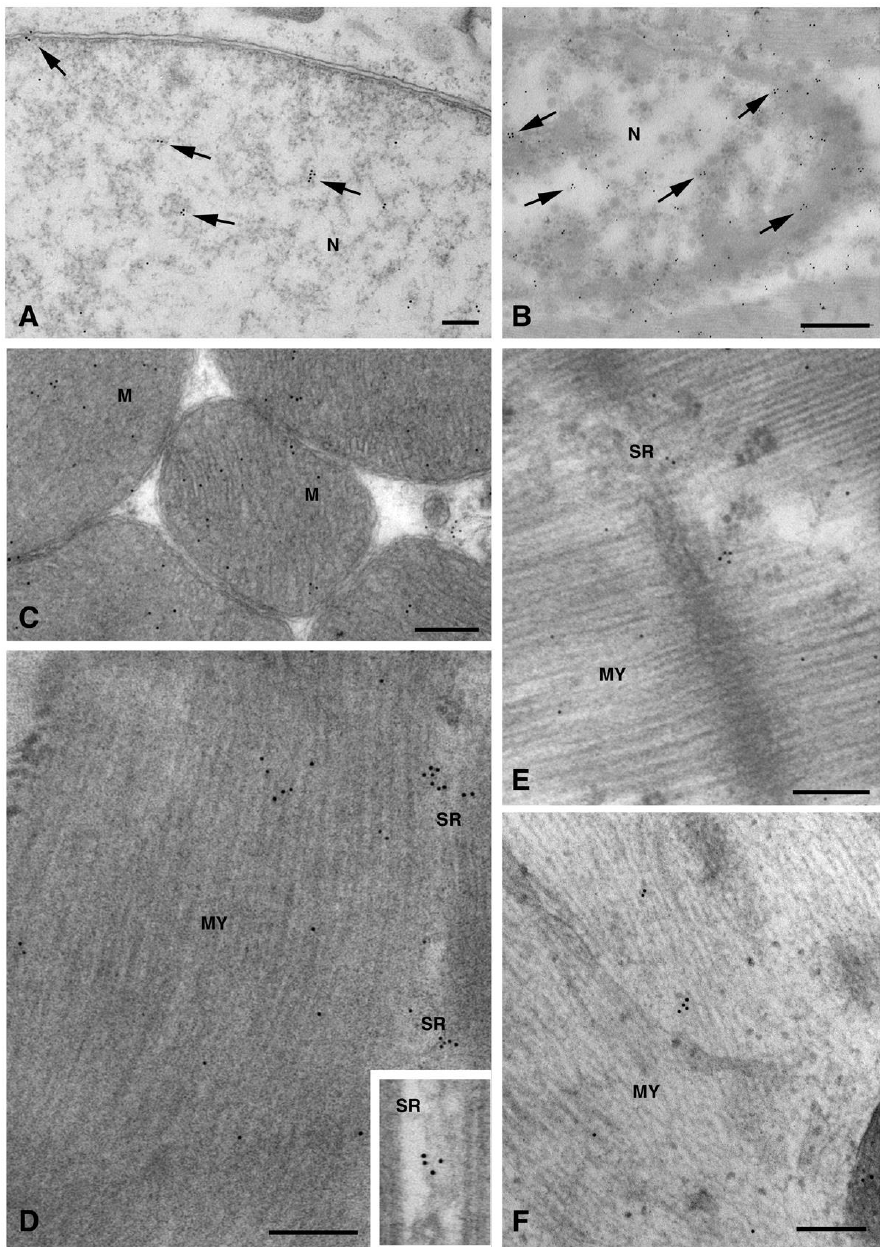
Figure 6. TEM immunogold analysis for Cx26 in non-canonical subcellular structures. Representative images of immunopositivity (arrows) in nucleus (N) of dH9c2 cells ( A ) and heart tissue cardiomyocytes ( B ). ( C – E ) Representative images of heart tissue cardiomyocytes evidencing immunogold particles on the inner membrane and cristae of mitochondria (M), on myofibrils (MY) and sarcoplasmic reticulum (SR). ( F ) Representative images of immunogold particles on myofibrils (MY) of dH9c2 cells. Scale bars 200 nm ( A , C – F ), 500 nm ( B ).